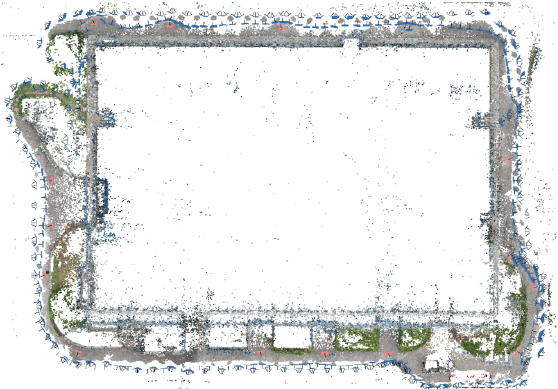
Figure 5: Plant view of the sparse reconstruction and camera network (blue frames) for the static approach with few GNSS camera positions. The images with GNSS data are in red.